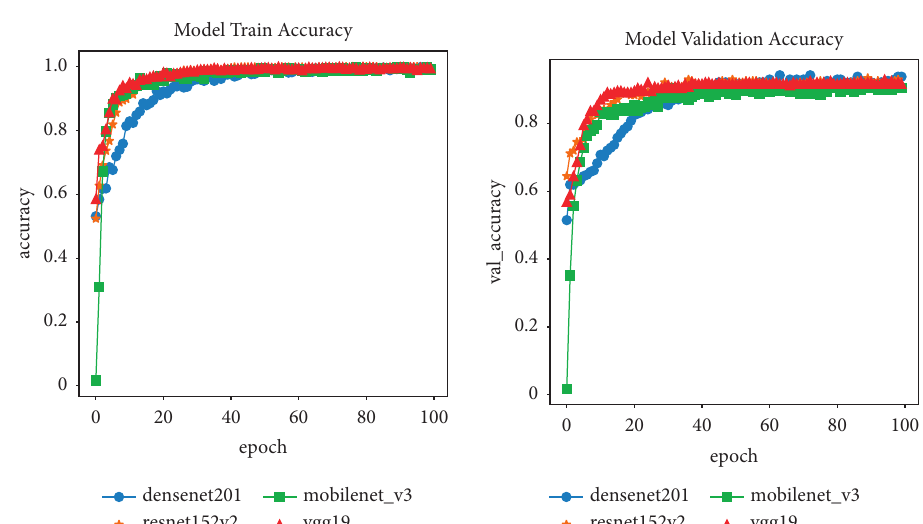
Figure 10: Accuracy of network architectures after data